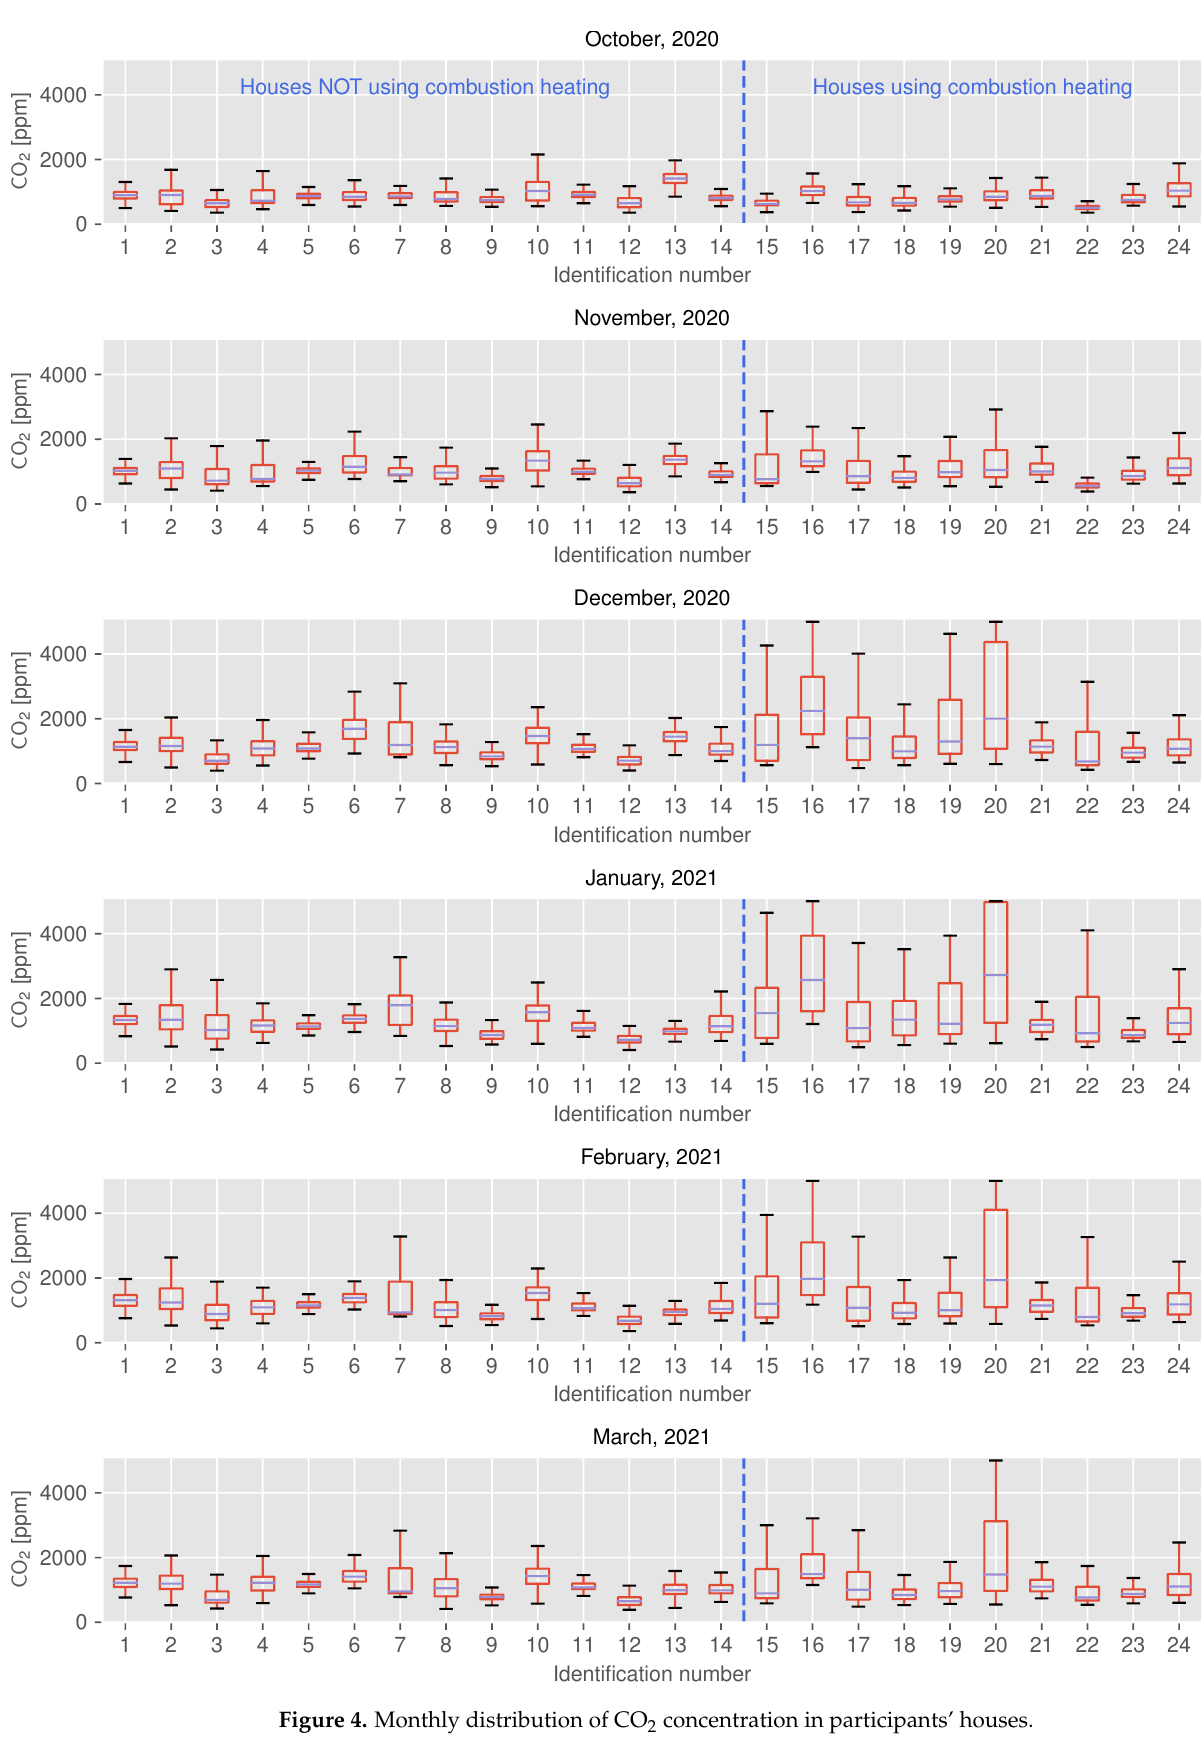
Figure 4. Monthly distribution of CO 2 concentration in participants’